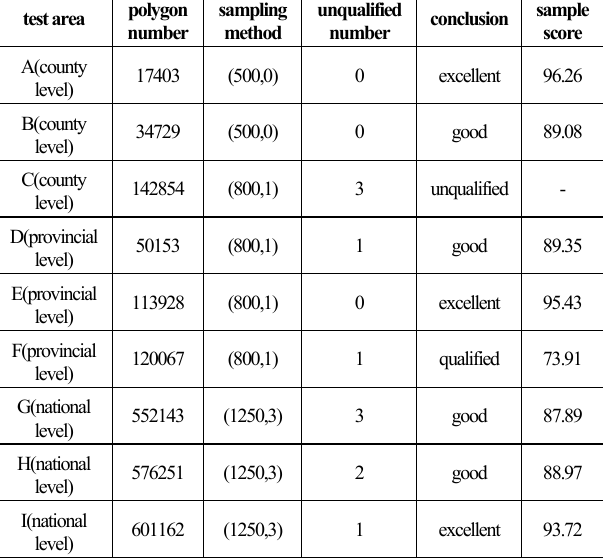
Table 4. Inspection and evaluation results of test